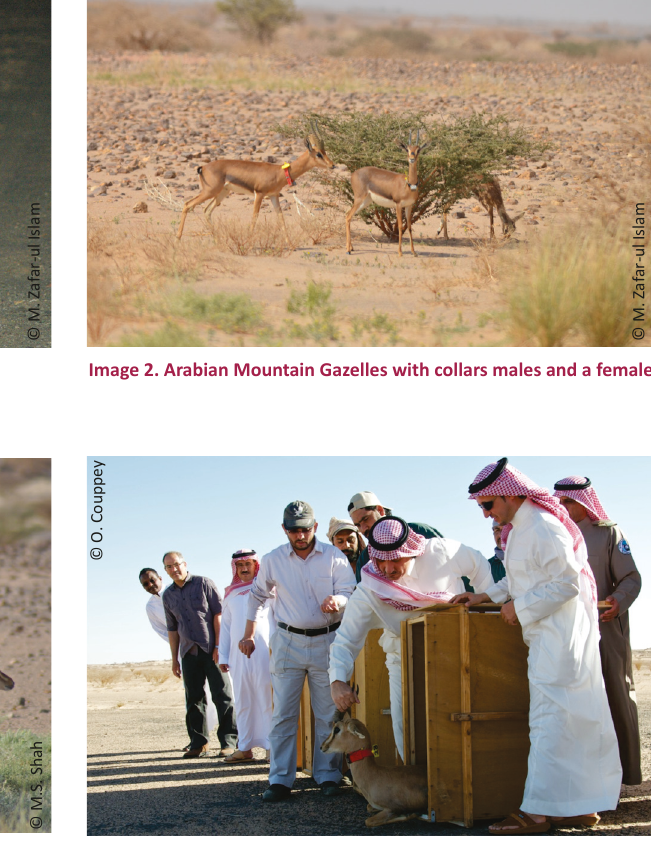
a h S h S . M . © Image 4. Arabian Mountain Gazelle released by HH Prince Bander (President of SWA)